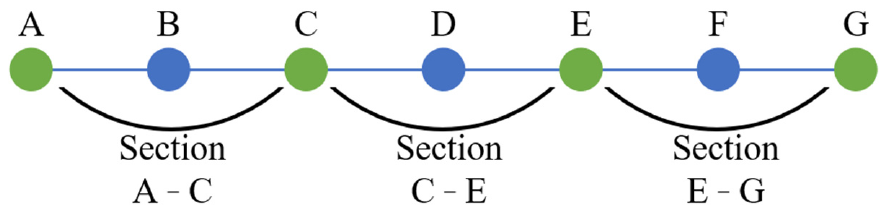
Figure 6. Sections and boundary stations.